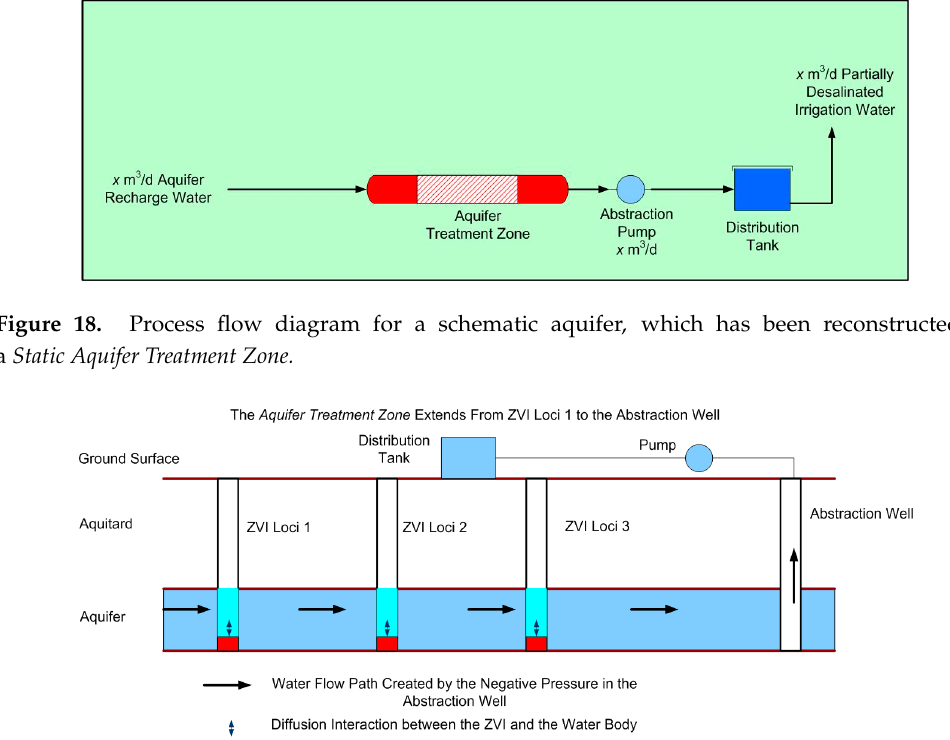
Figure 19. Cross section through a schematic Aquifer Treatment Zone. The zone containing the ZVI pellets/cartridges is colored red.